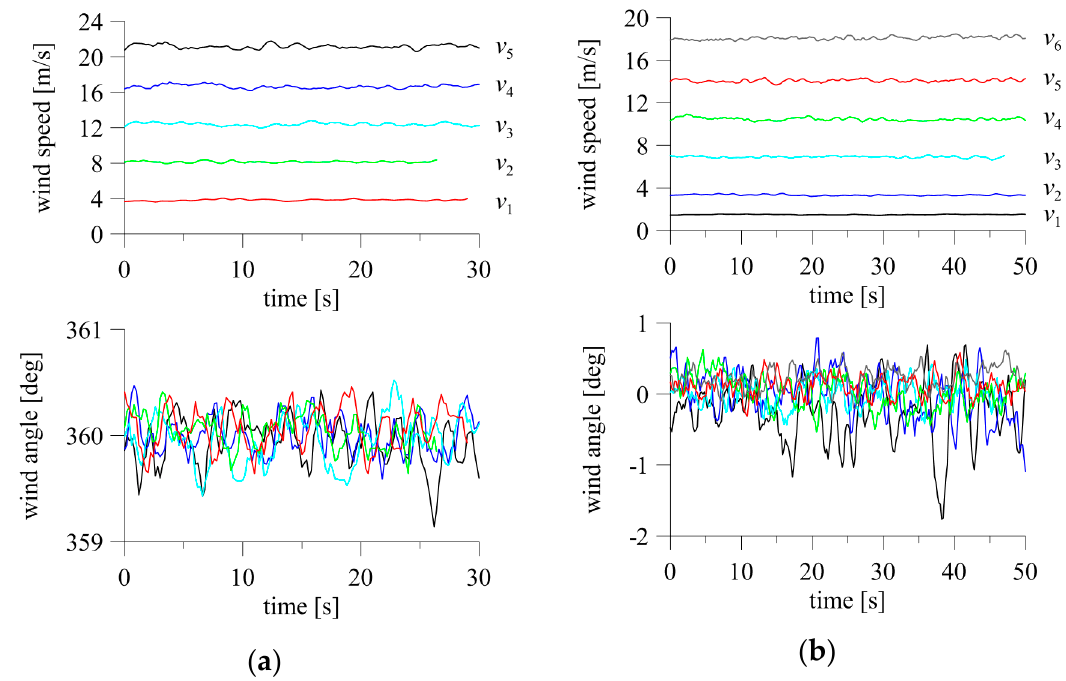
Figure 15. Fluctuations of wind angle and speed at changing flow speed for ( a ) 2D anemometer and ( b ) 3D anemometer.